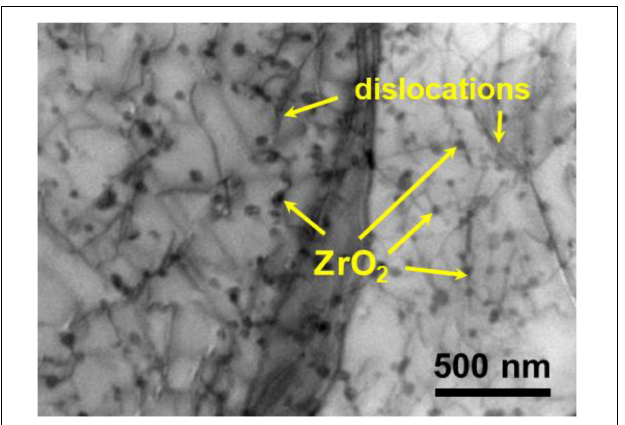
FIGURE 11 | Dislocations around ZrO 2 particles in FSPed AZ31/ZrO 2 composite (Z3-3P specimen).